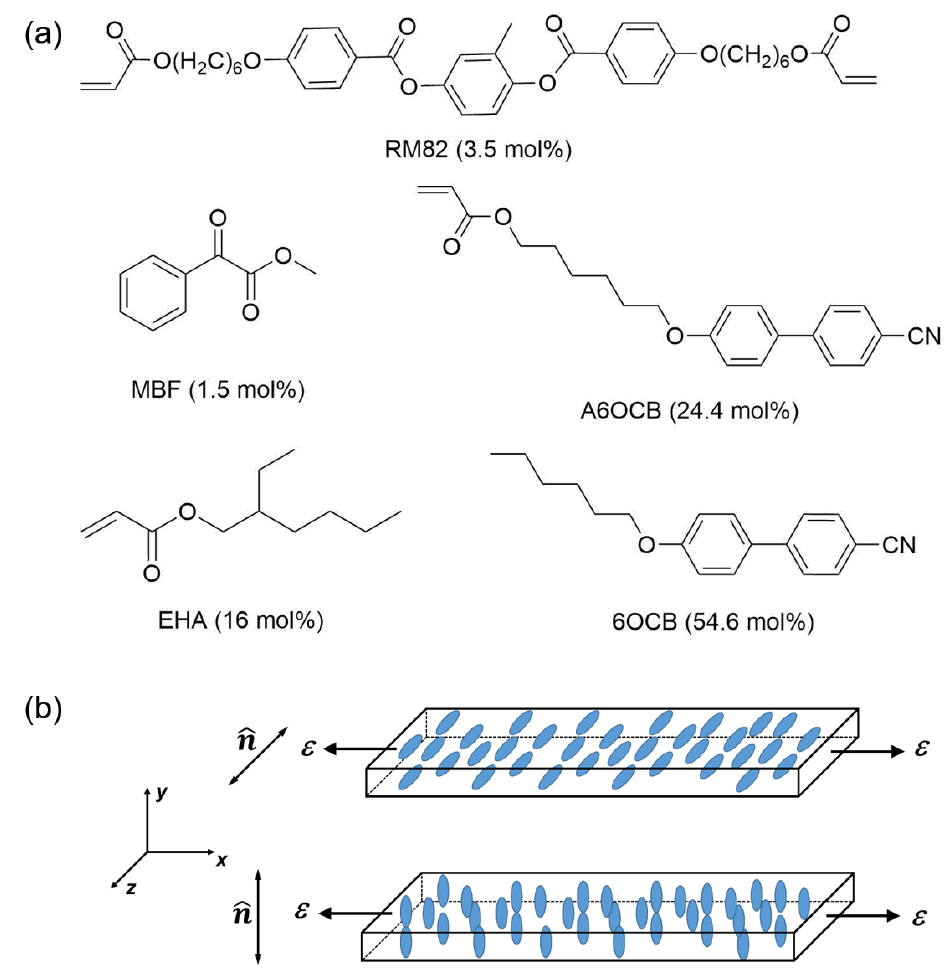
Figure 2. ( a ) The molecular structures of the LCE monomers with proportion in the precursor mixture indicated. The composition is similar to [7]. ( b ) Diagram describing the undeformed sample geometry with the liquid crystal director parallel to the z -axis for the planar LCE and to the y -axis for the homeotropic LCE. In this work, deformations ( ε ) are applied along the x -axis. Table 1. Chemical composition of the LCE.